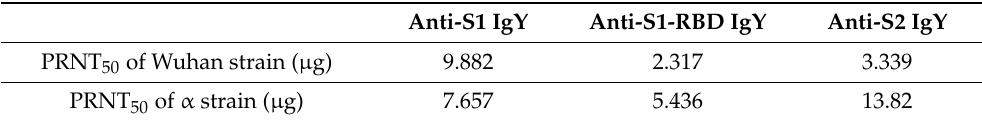
Figure 2. The plaque reduction neutralization test (PRNT) was used to measure the neutralizing potential of IgYs specific for S1, S1-RBD, and S2 subunits against different strains of SARS-CoV-2. Vero E6 cells were treated with a mixture of SARS-CoV-2 (Panel ( A ): Wuhan strain; Panel ( B ): Alpha strain) and different amounts of IgY proteins specific for S1, S1-RBD, S2 subunits, and mock control IgY. After treatment, viral titers were evaluated by plaque assays. PRNT50 is known as the standard method for measuring neutralizing antibodies. To assess the PRNT50 of each neutralizing antibody that can suppress 50% of infectious viruses, the antibody neutralizing curves for each SARS-CoV-2 strain were plotted (Panel ( C ): Wuhan strain; Panel ( D ): Alpha strain). Data are presented as mean ± SD of three independent experiments. Table 1. PRNT 50 of the indicated strain of SARS-CoV-2.